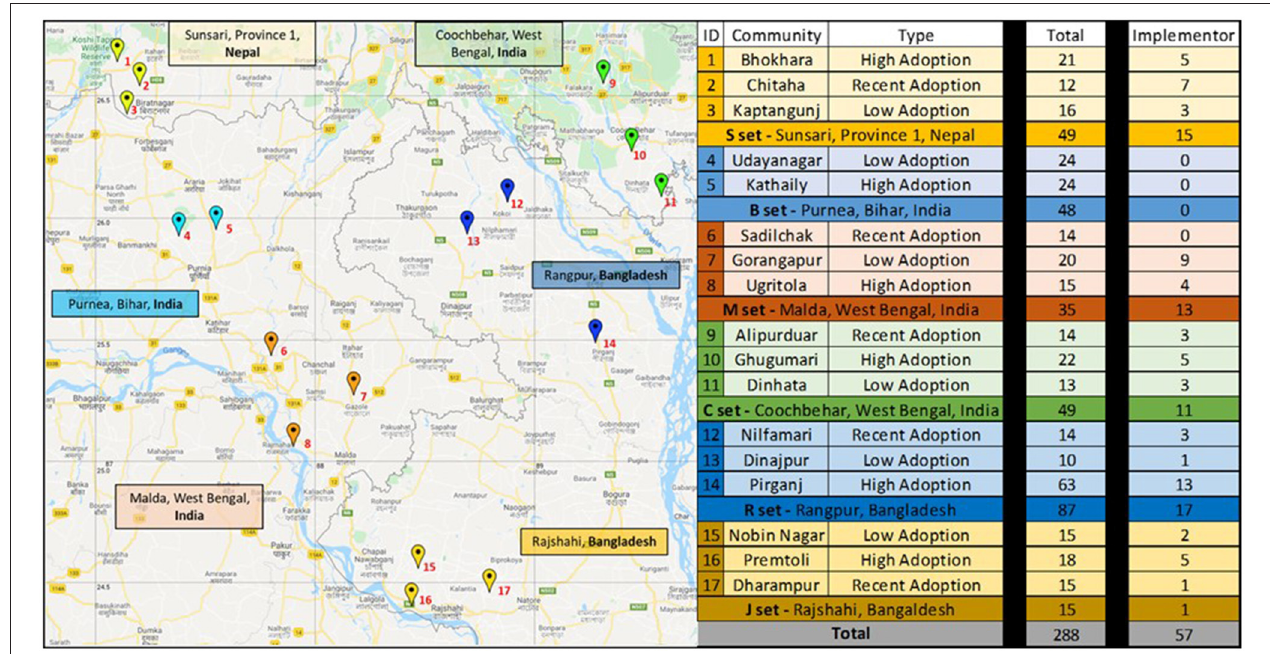
FIGURE 1 | Study locations in Eastern Gangetic Plains, covering six locations and 17 communities.